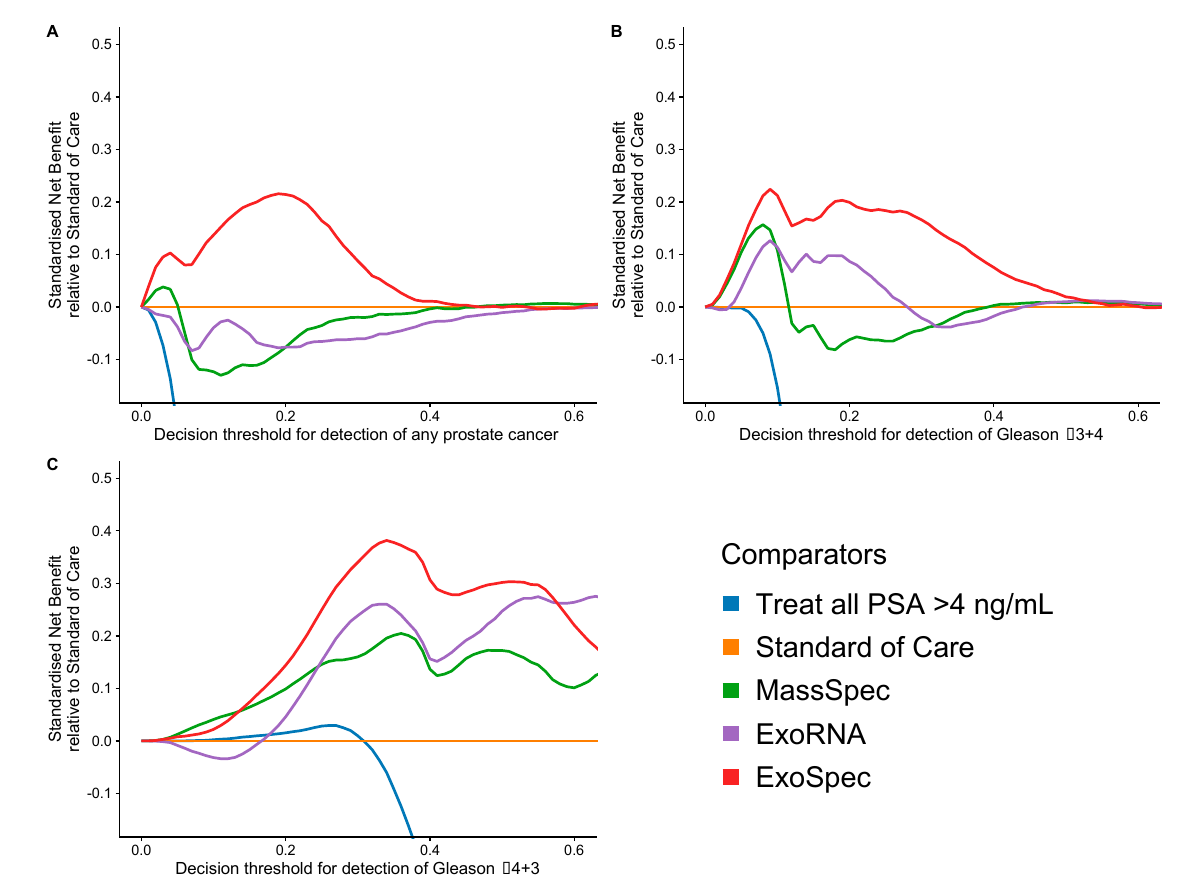
Figure 4. Estimation of standardised net benefit (sNB) of adopting each comparator model into clinical practice, displayed as decision curves, relative to standard of care. Accepted risk thresholds for the clinician before agreeing to biopsy are shown on the x-axis—decision threshold. For example, a clinician may accept up to a 25% perceived risk of significant cancer before recommending biopsy to a patient, equating to a decision threshold of 0.25. Each panel shows the relative sNB of a different biopsy outcome result when compared to standard of care: ( A ) detection of any prostate cancer, regardless of Gleason; ( B ) detection of Gleason ≥ 3 + 4; ( C ) detection of Gleason ≥ 4 + 3. The colour of each line represents mode model used: orange—biopsy of patients according to current standard of care, green—biopsy patients based on the MassSpec model, purple—biopsy patients based on the ExoRNA model, and red—biopsy patients based on the ExoSpec model. Data presented here were calculated from 1000 stratified bootstrap resamples of the available data to match the disease proportions reported from the control arm of the CAP study [37]. The mean sNB from these resamples was calculated and presented here.